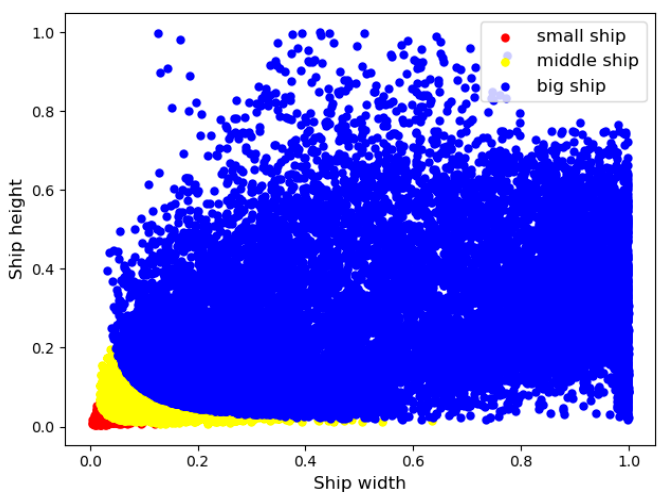
Figure 7. Visualizing the distribution of ship size and number in the dataset.